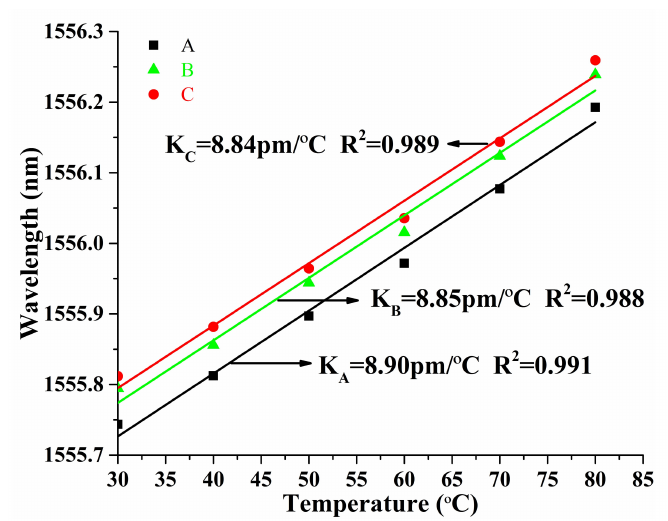
Figure 7. Linear relationship between the wavelength of extreme point of the reflection spectra and the